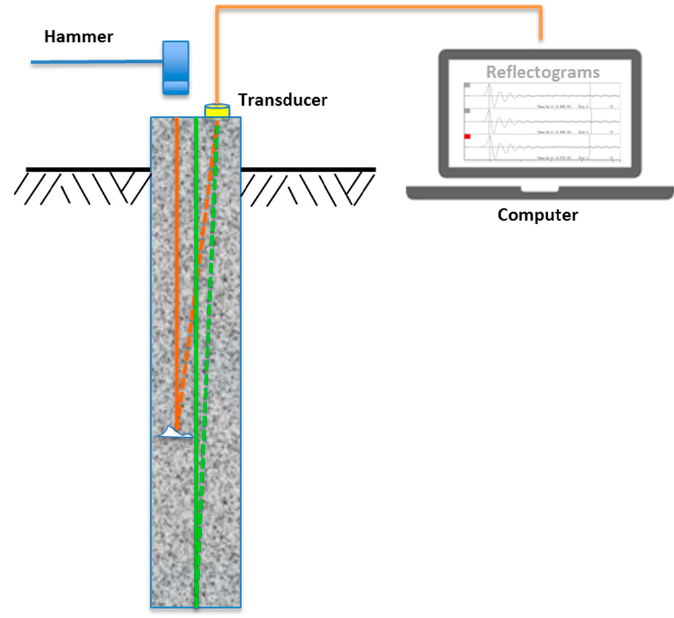
Figure 1. Schematic view of low strain pile integrity testing.